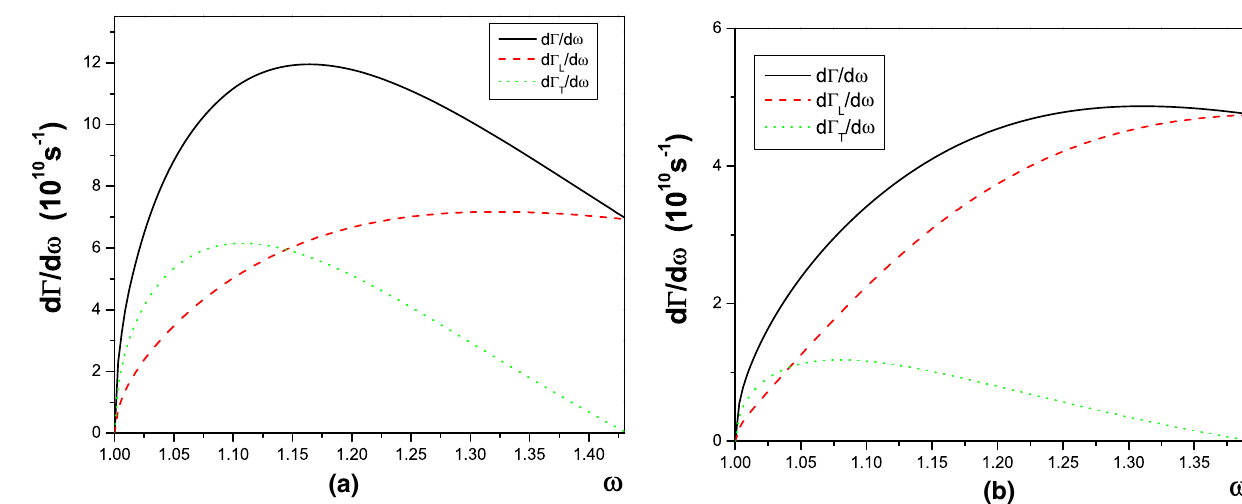
Fig. 3 Differential decay rates d (cid:15)/ d ω for the decay (cid:2) b → (cid:2) c ( a ) and (cid:3) b → (cid:3) c ( b )